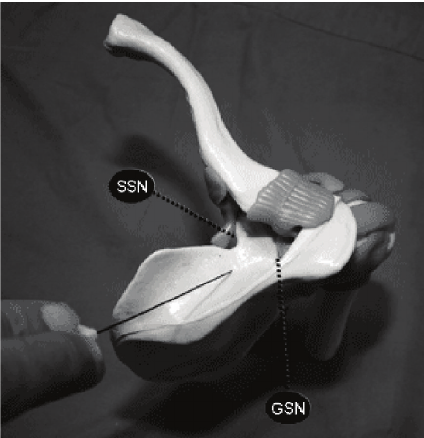
Figure 7: Anatomic representation of the superior view of the Meier technique. Note the needle is in the supraspinous fossa, demonstrat- ing the 30 ◦ of ventral inclination. The suprascapular nerve enters the groove at the suprascapular notch (SSN) and winds laterally around the greater scapular notch (GSN) (Price [3]). (Reprinted with permission.)